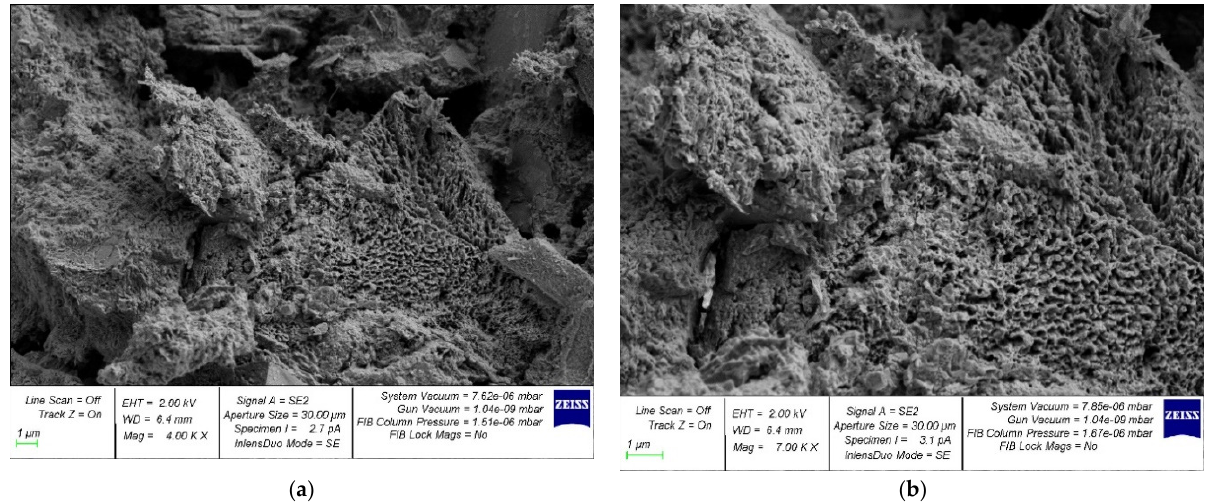
Figure 9. Photo of vibrocentrifuged hardened cement paste samples: ( a ) at 4000× magnification; ( b ) at 7000× magnification.